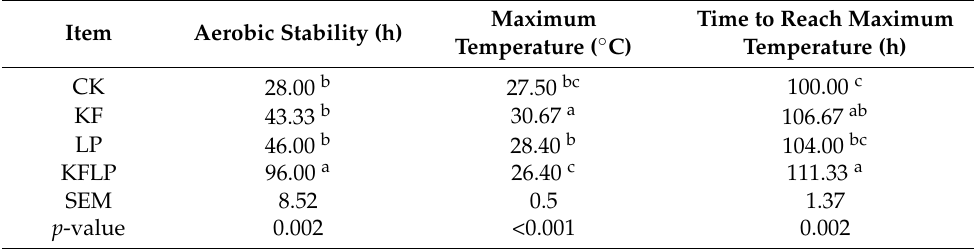
Figure 1. The temperature dynamics of forage rape silages fermented with KF and LP during the aerobic exposure. CK: the control; KF: konjac flour; LP: Lactiplantibacillus plantarum ; KFLP: konjac flour + Lactiplantibacillus plantarum . Table 3. The aerobic stability of forage rape silages fermented with KF and LP.